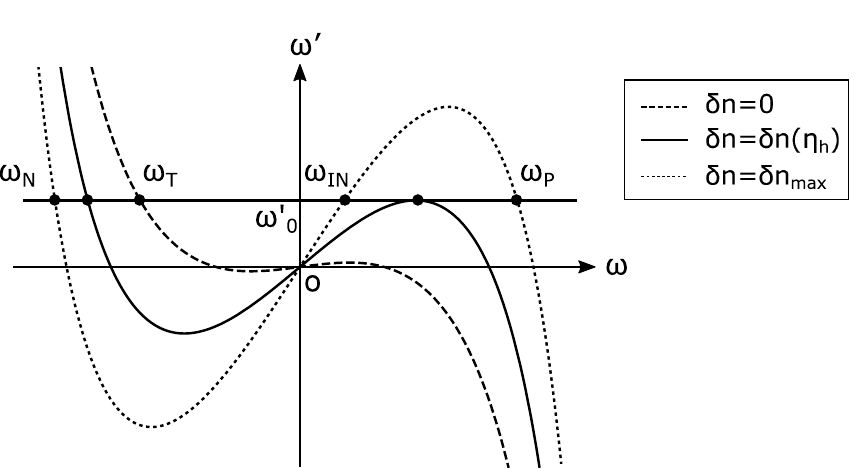
Figure 4. The relation between the frequencies in the laboratory frame ω and the comoving frame ω ′ by the Doppler shift. The dashed, solid, and dotted curved lines represent the relation at the perturbed index δ n δ n max , respectively. The horizontal line shows the invariant frequency ω ′ 0 in the δ n δ n (η h ) , and δ n = = comoving frame and the intersections with the curved lines correspond to the